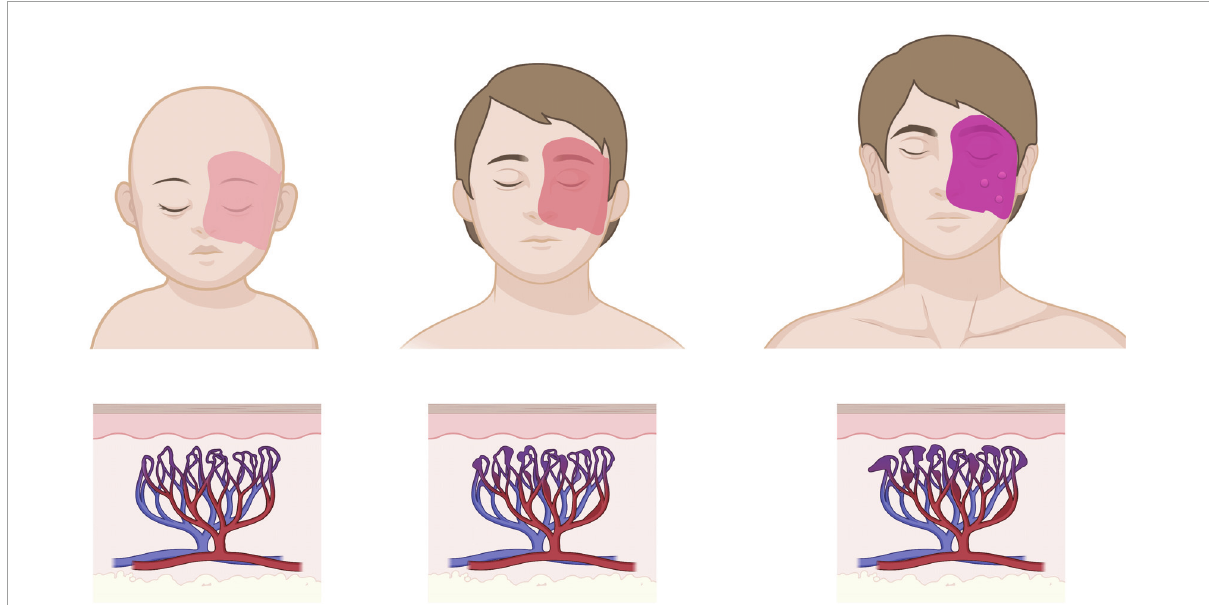
FIGURE1 Age progression of cutaneous PWB. Birthmark is usually apparent from birth as a light pink patch that can get darker with age, corresponding to progressive dilation of affected capillaries in the dermis. Patients in adulthood may develop soft tissue hypertrophy or nodularity in the absence of clinical intervention. Images created using